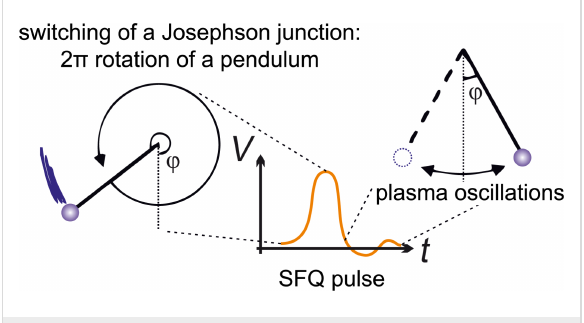
Figure 1: Voltage pulse on a Josephson junction corresponding to a SFQ transition and its mechanical analogy with the rotation of a pendulum.